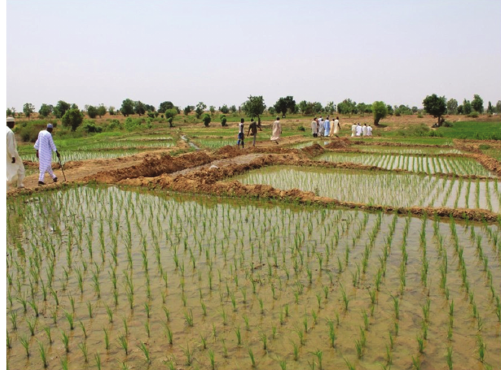
Figure 4: A newly developed sawah field located in an inland valley in Jega, Kebbi State of